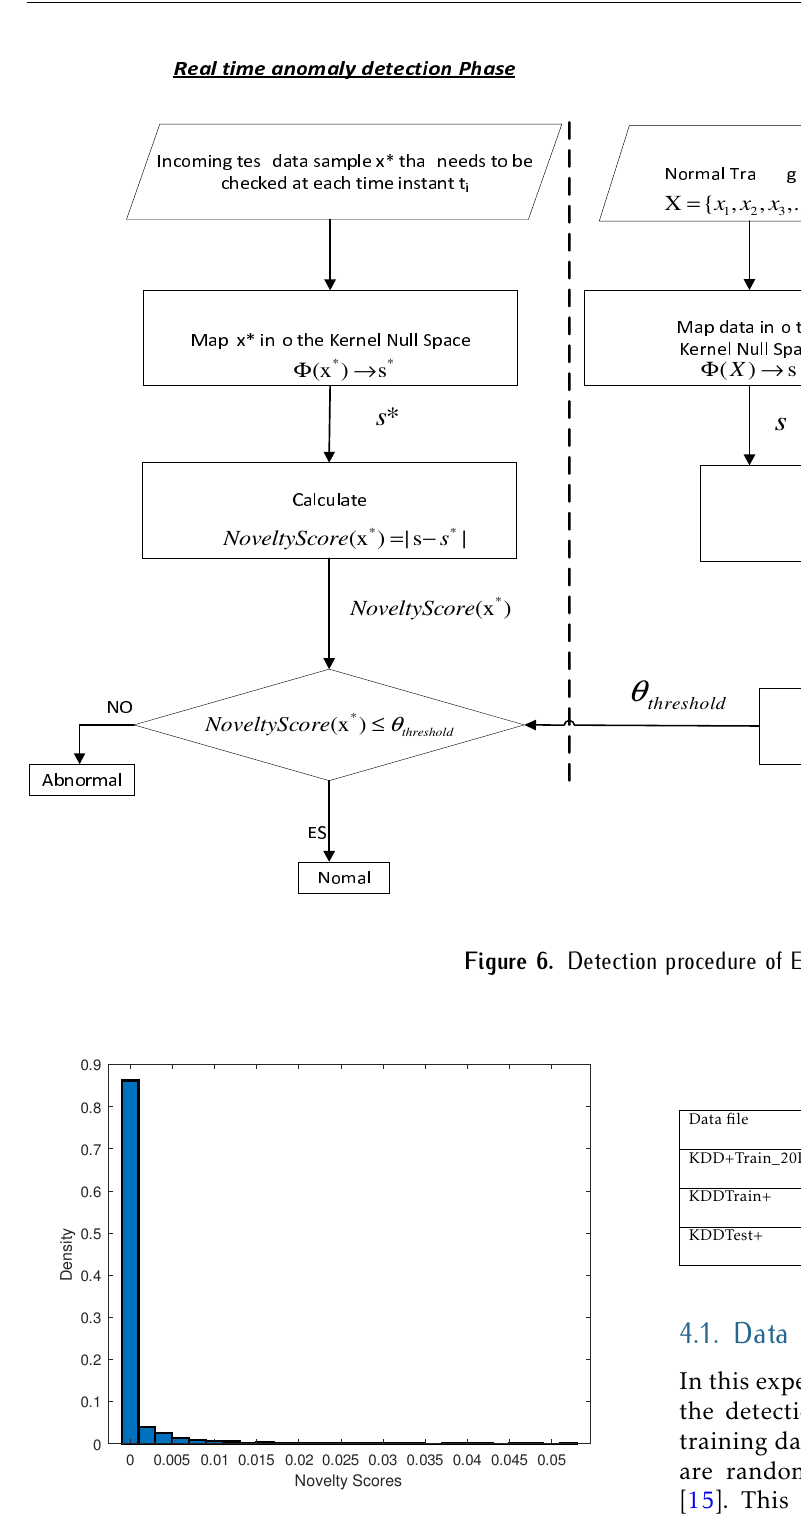
Figure 7. Probability Density Distribution of Novelty